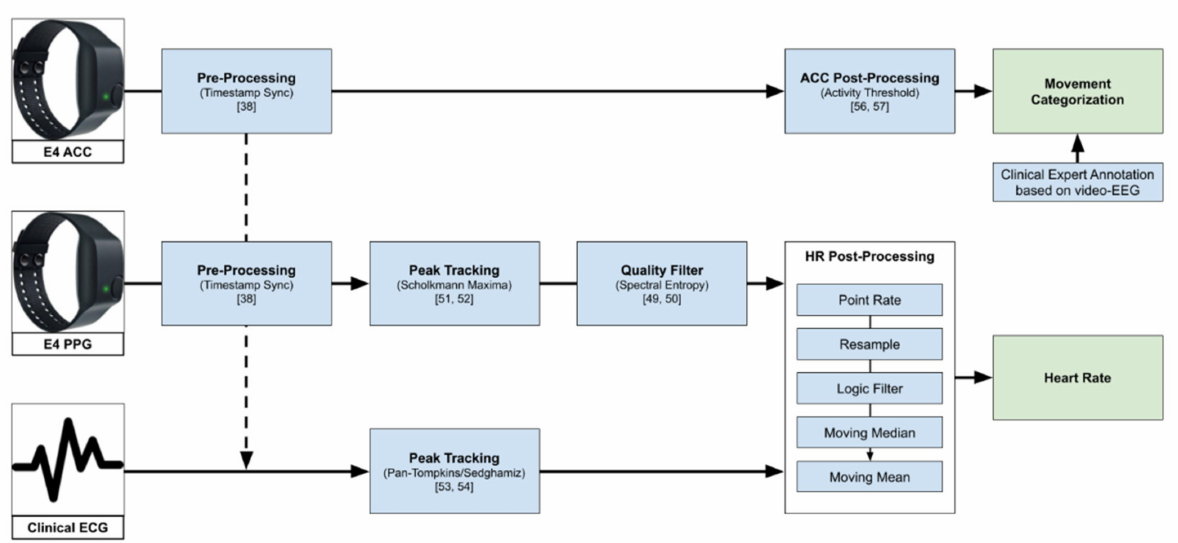
Figure 1. Overview of the data processing pipeline, from raw data to heart rate used in the further analysis, and the movement categorization based on ACC (see Section 3.4). The logic filter here describes the step of filtering point rate values that are not in the range of 40–180 bpm or changed by more than 20% from one value to the